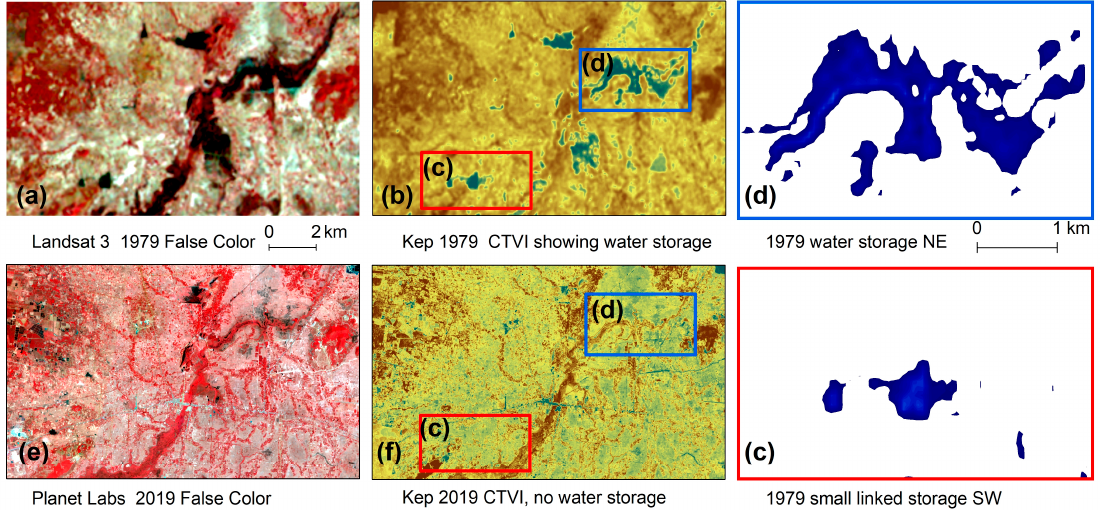
Figure 12. Water storage features in Kep Province, Cambodia. ( a ) 1979 false color infrared; ( b ) same imagery, CTVI processed; ( c ) and ( d ) enlarged views of water storage areas visible in 1979; ( e ) 2019 Planet Labs imagery in false color composite; ( f ) same 2019 imagery, CTVI processed.